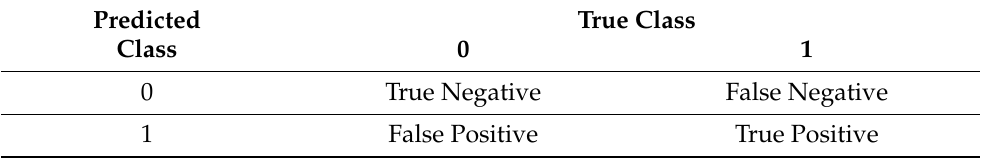
Table 3. Confusion matrix for binary